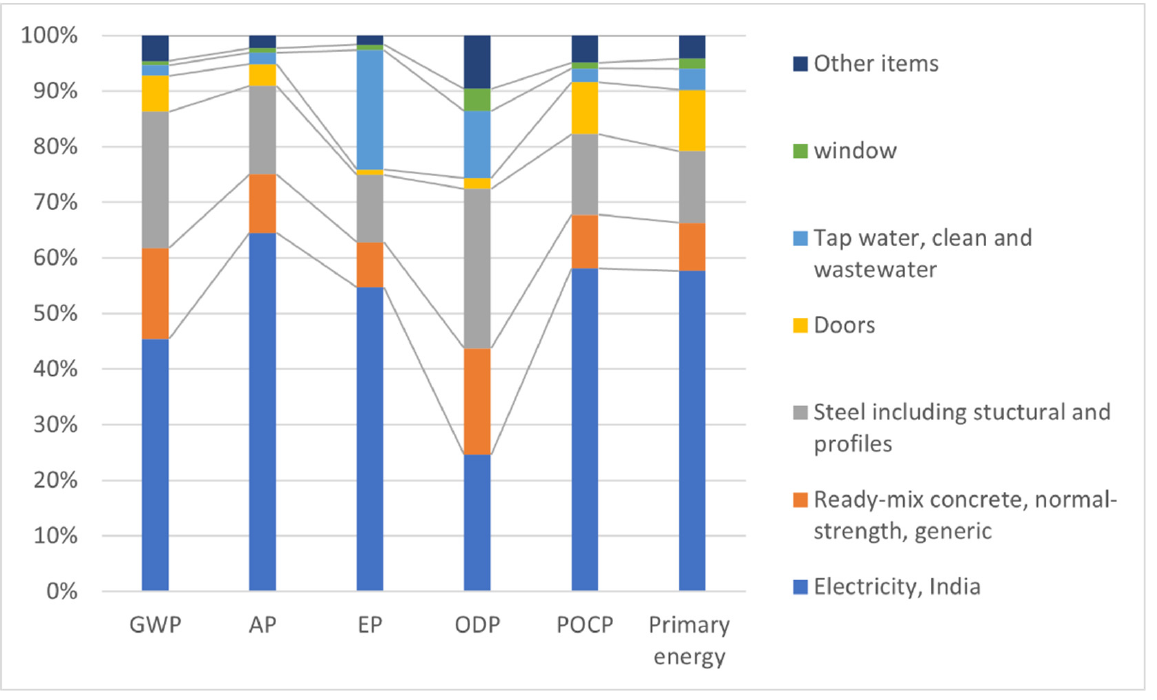
Figure 3. Life cycle impact by materials.